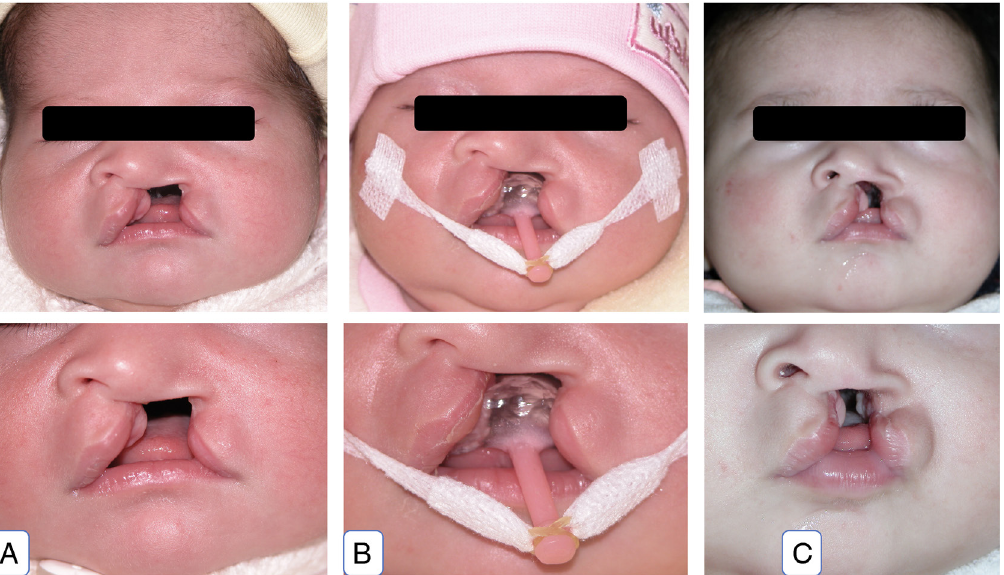
Figure 1. (A) When the patient applied to the clinic in the neonatal period. (B) Appearance of the appliance used for NAM before surgery. (C) Final state before lip